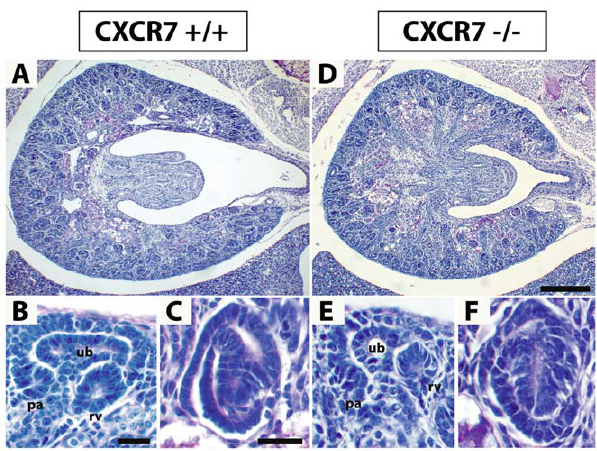
Figure 4. Histological analysis of CXCR7-deficient kidneys. Kidney sections of E16.5 wildtype (A–C) and CXCR7 deficient littermates (D–F) were stained with periodic acid-Schiff (PAS) reagents. ( A,D ) Macroscopic images demonstrate that the overall kidney morphology is normal in the CXCR7 knockout embryo. ( B,C,E,F ) Microscopic views of pretubular aggregates (pa), renal vesicles (rv), ureteric buds (ub) (B,E), and S-shaped bodies (C,F) do not reveal any abnormalities in the CXCR7 knockout kidney. Scale bars equal 200 m m (D) and 20 m m (B,C).